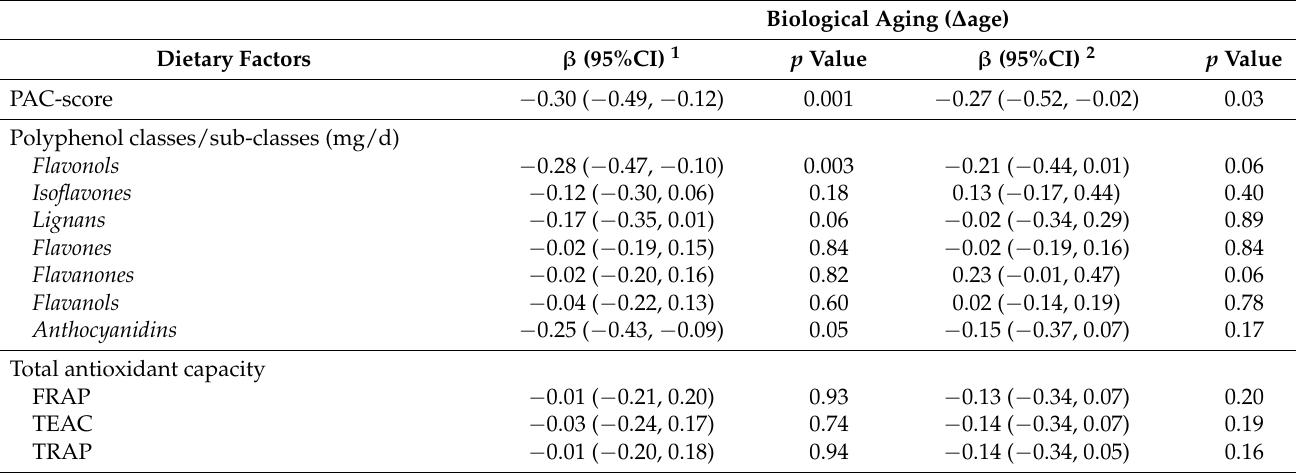
Table 2. Association of the PAC-score, polyphenol classes and sub-classes and total antioxidant capacity with ∆ age, by means of regression coefficients ( β ) with 95% confidence interval